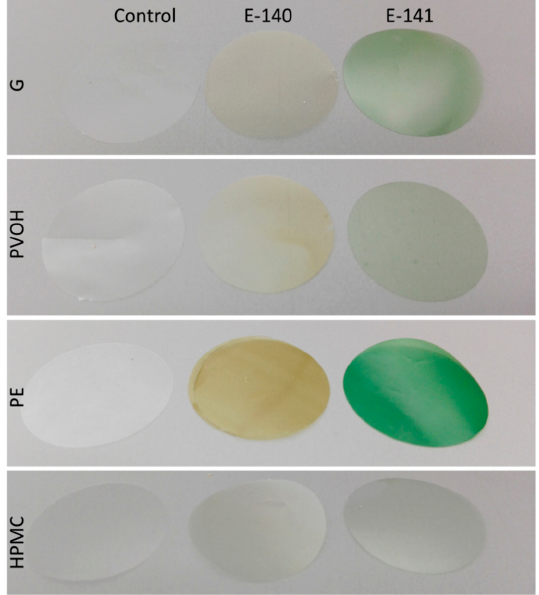
Figure 2. Images of the PET films coated with G, PVOH, HPMC, and PE for the control and the films containing chlorophyllins (E-140 and E-141).